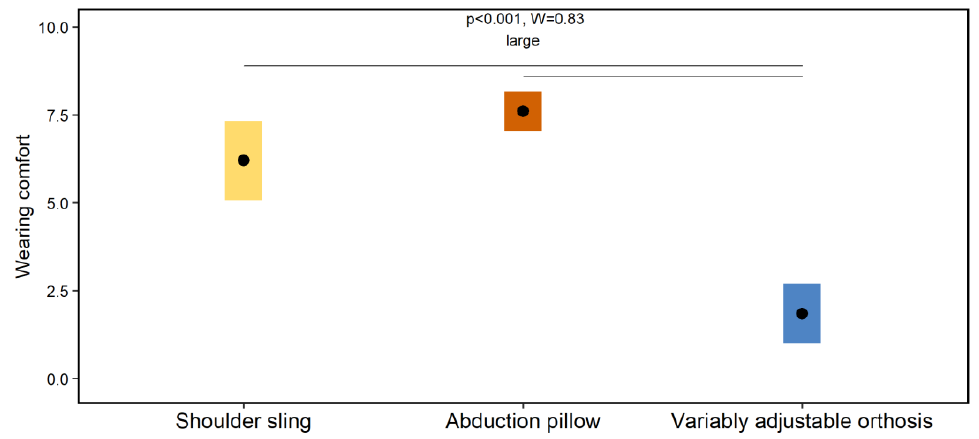
Figure 5. Effects of the orthoses on the wearing comfort during the activities of daily living. Note: Diamonds and bars indicate mean ratings and 90% confidence intervals, respectively. Horizontal lines indicate significant post-hoc effects.